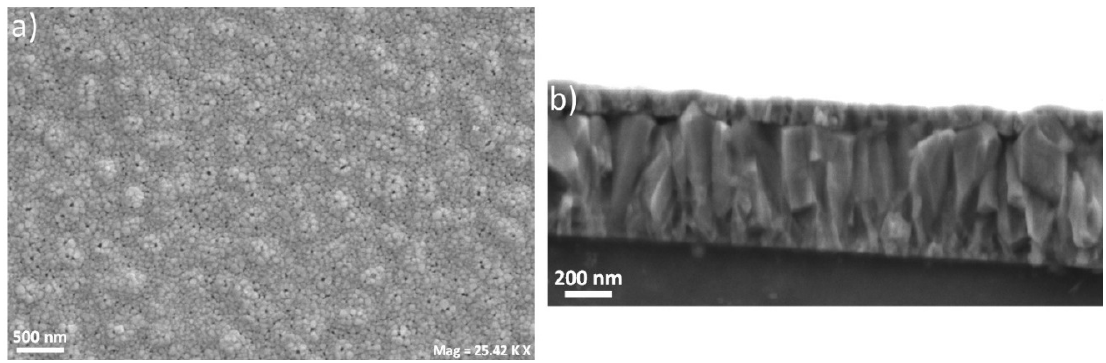
Figure 2. ( a ) Top down and ( b ) cross section SEM images of the 20L_800 film.